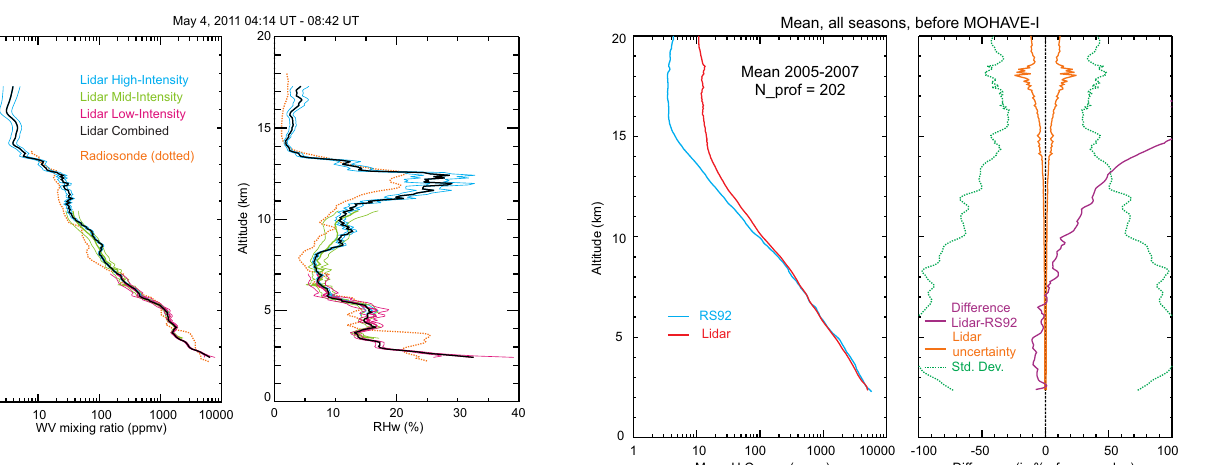
Fig. 6. An example of the construction of the final (black) water va- por (left) and Relative Humidity (right) profiles from the three chan- nel ranges (pink: low-intensity, green: mid-intensity, and blue: high intensity). The lidar profiles total uncertainty is over-plotted using thin solid curves, and a co-located radiosonde profile is over-potted using a dotted orange curve.